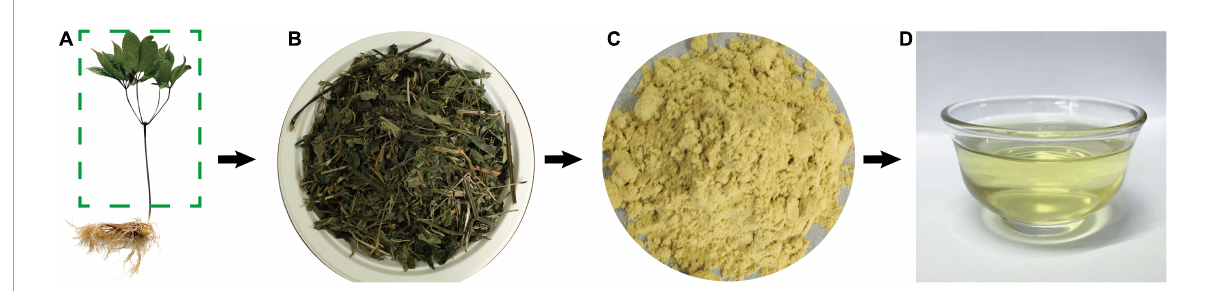
FIGURE3 The manufacturing process of SLPN-instant beverage. (A) Fresh SLPN material; (B) SLPN material dried at 25 ◦ C shade-air; (C) SLPN-instant beverage; (D) infusion of SLPN-instant beverage.